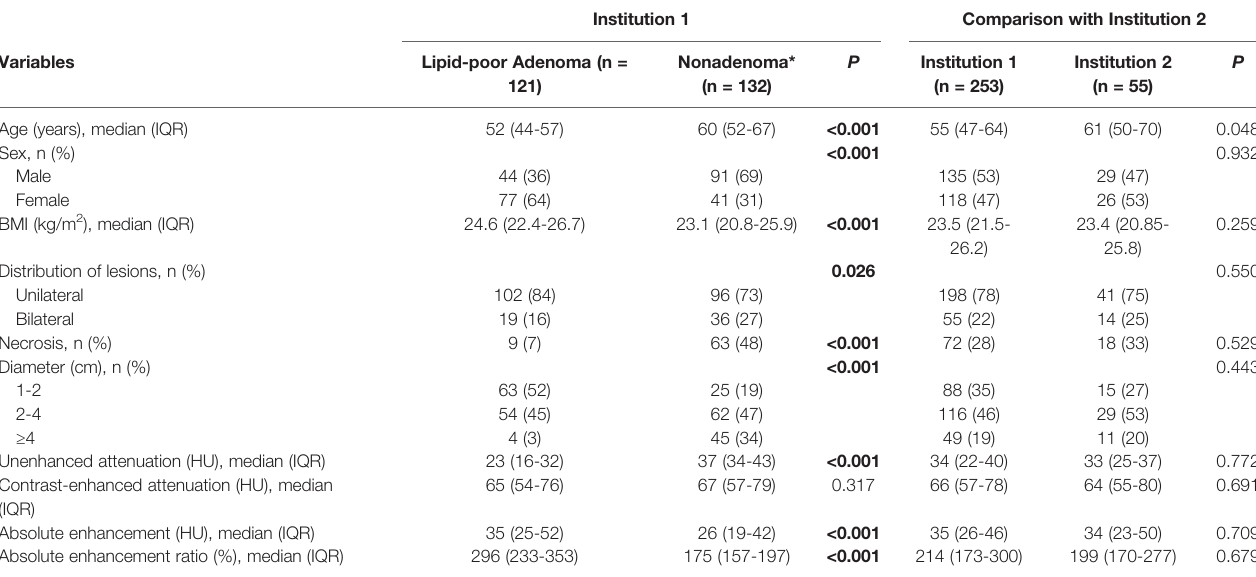
TABLE 1 | Characteristics of Institution 1 and Institution